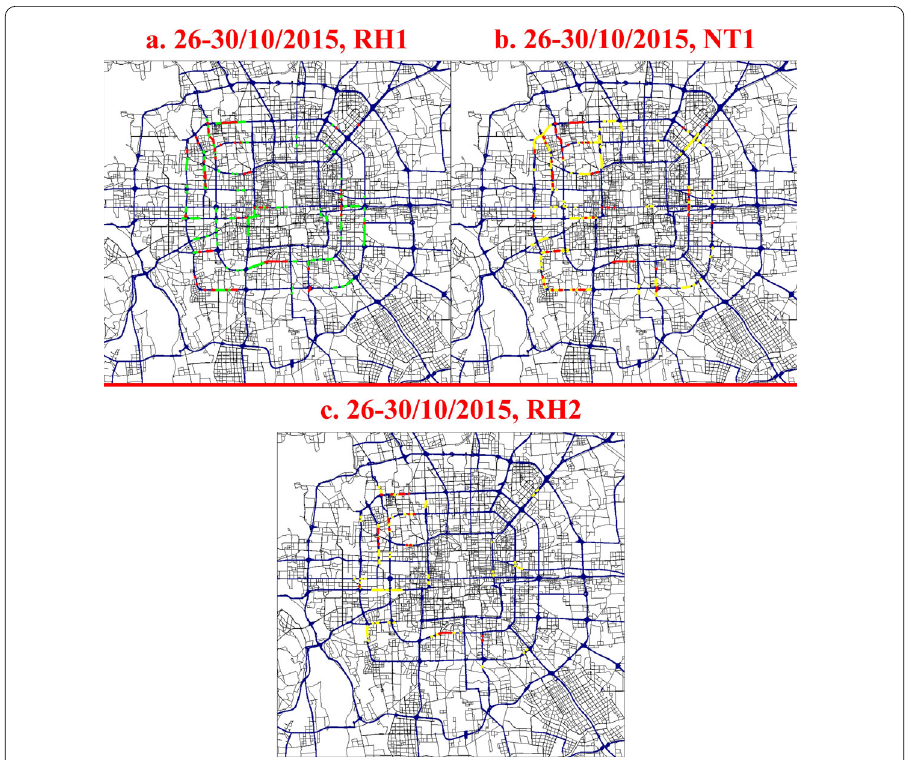
Figure 10 Road sections with 20% largest mean impact distances on the map. ( a ), ( b ) During RH1 and NT1. The map shows 223 nodes in RH1 (green lines) and 227 nodes in NT1 (yellow segments), with 77 overlapping nodes (red segments). The percentages of the overlapping nodes among the selected 223 and 227 nodes in RH1 and NT1 are 34.53% and 33.92%, respectively. ( c ) During RH2. On the map we show 116 nodes in RH2 (yellow segments), with 32 overlapping nodes with RH1 (red segments). The percentage of the overlapping nodes among the 116 selected hub nodes is 27.59%. The data is during 26–30 Oct. 2015, N = 4530, L = 900, and τ max = 150